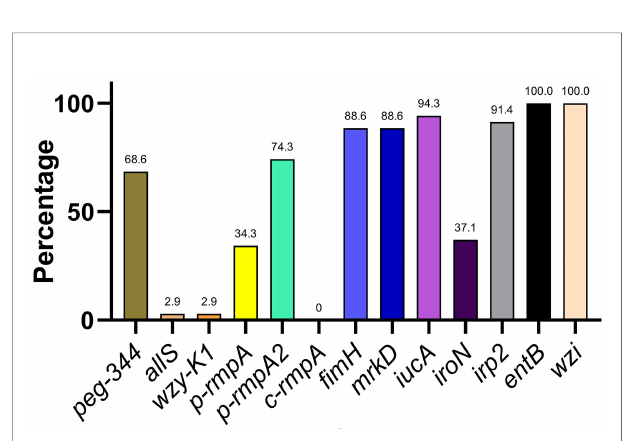
FIGURE 3 | Distribution of key virulence genes among putative bla KPC (+)-HvKP and Hv- bla KPC (+)-KP strains. bla KPC , beta-lactamase K. pneumoniae carbapenemase gene; bla KPC (+)-HvKP, bla KPC (+) hypervirulent K. pneumoniae ; Hv- bla KPC (+)-KP, hypervirulent bla KPC (+) K. pneumoniae